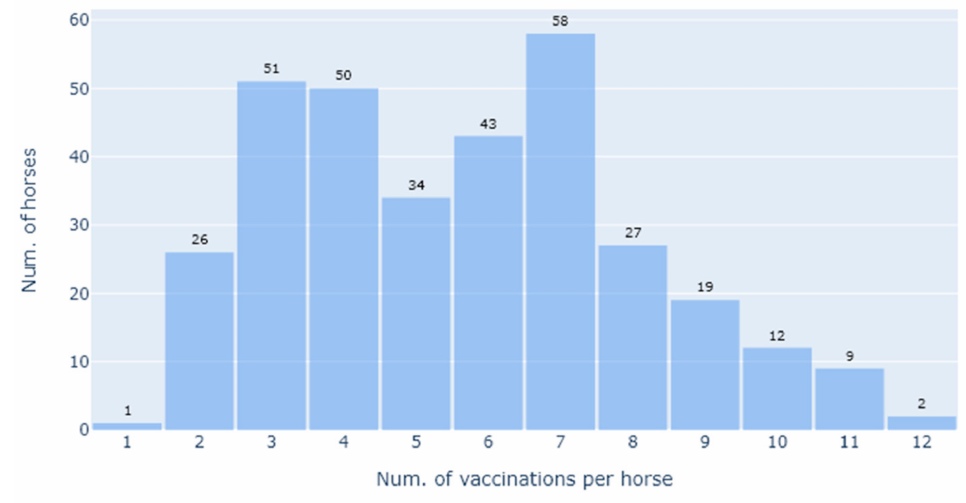
Figure 1. Bar chart showing the number of Equivac ® HeV Hendra virus vaccinations per horse at the time of sampling for the SNT, ranging from 1–12, with the count being the number of horses. In total there were data from 332 horses used in this study.